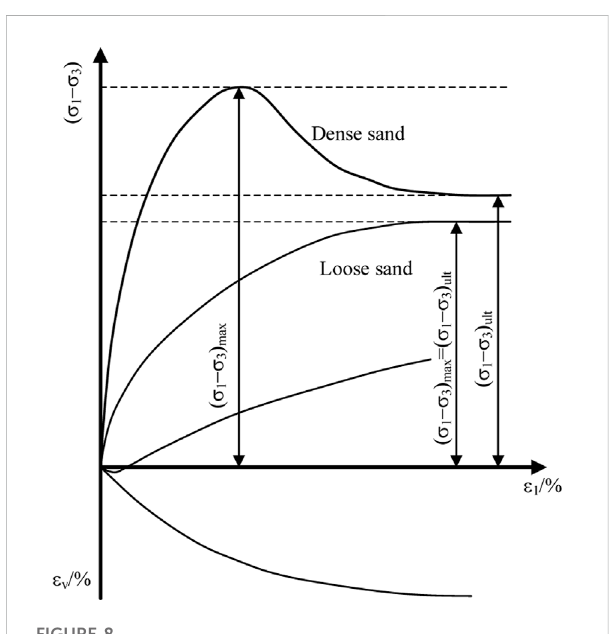
FIGURE 8 Triaxial test results for loose and concentrated